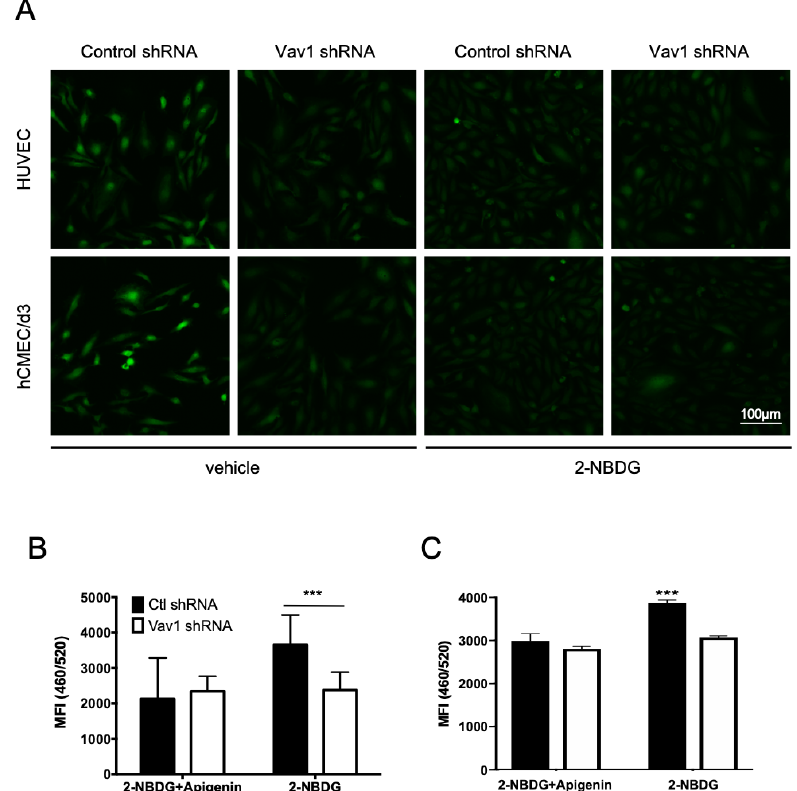
Figure 2. Vav1 regulates glucose uptake in endothelial cells. ( A ) HUVEC and hCMEC/d3 cells with control or Vav1 shRNA were starved in glucose-free medium for 1 h before the addition of 2-NBDG under hypoxic conditions with or without apigenin. After 1 h of incubation, cells were fixed with paraformaldehyde and observed by confocal microscopy. HUVEC ( B ) and hCMEC/d3 ( C ) cells with control or Vav1 shRNA in a 96-well plate were starved in glucose-free medium for 1 h and then treated with 2-NBDG with or without apigenin under hypoxic conditions for an hour. Mean fluorescence intensity (MFI) was measured to quantify 2-NBDG uptake levels (quadruplet mean ± SD). *** p < 0.001.